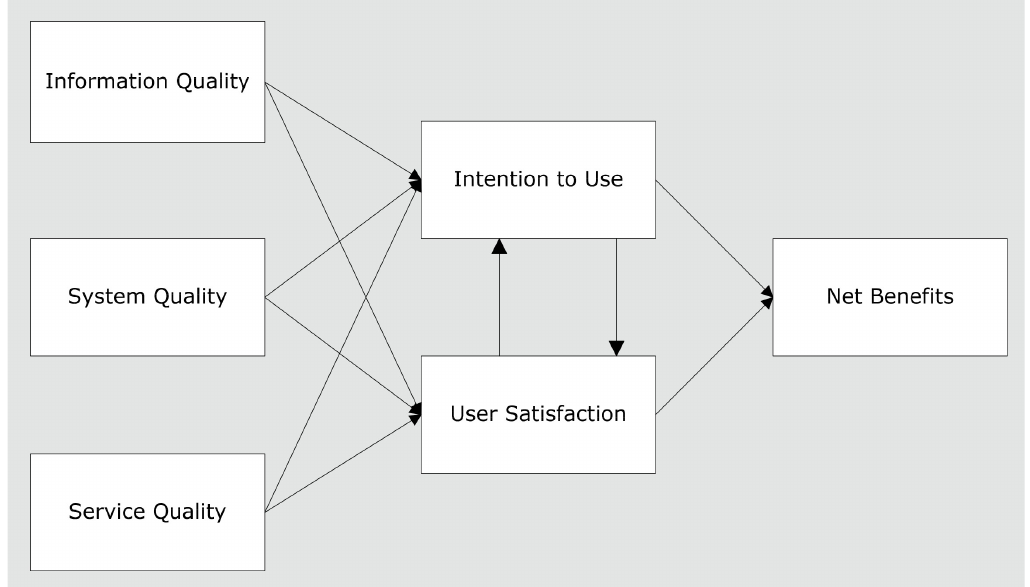
Figure 2. Information system success model (Delone &